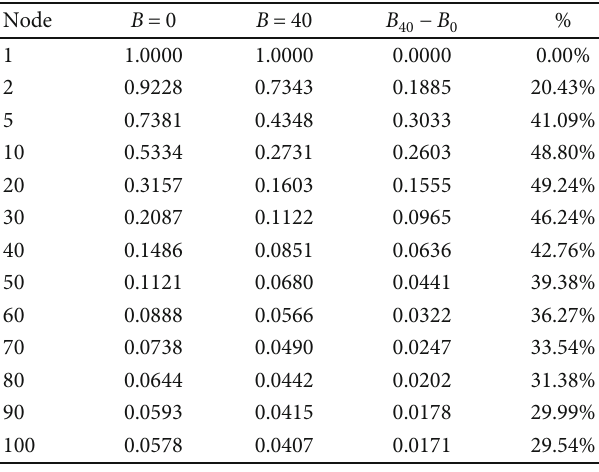
Table 5: Comparison of radiation values B = 100